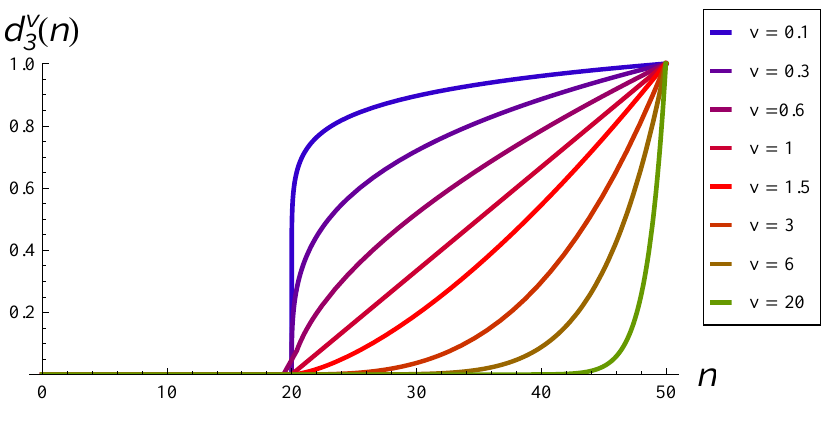
( n ) for v from 0.1 to 3